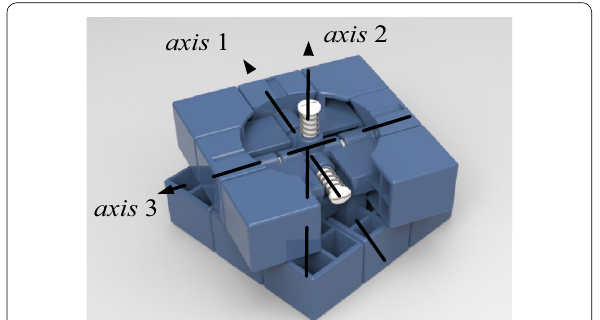
Figure 1. The Rubik’s Cube